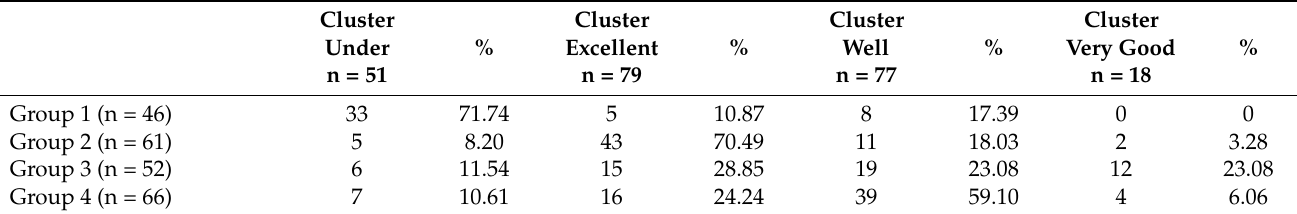
Table 5. Percentage of membership for each intervention group with respect to each